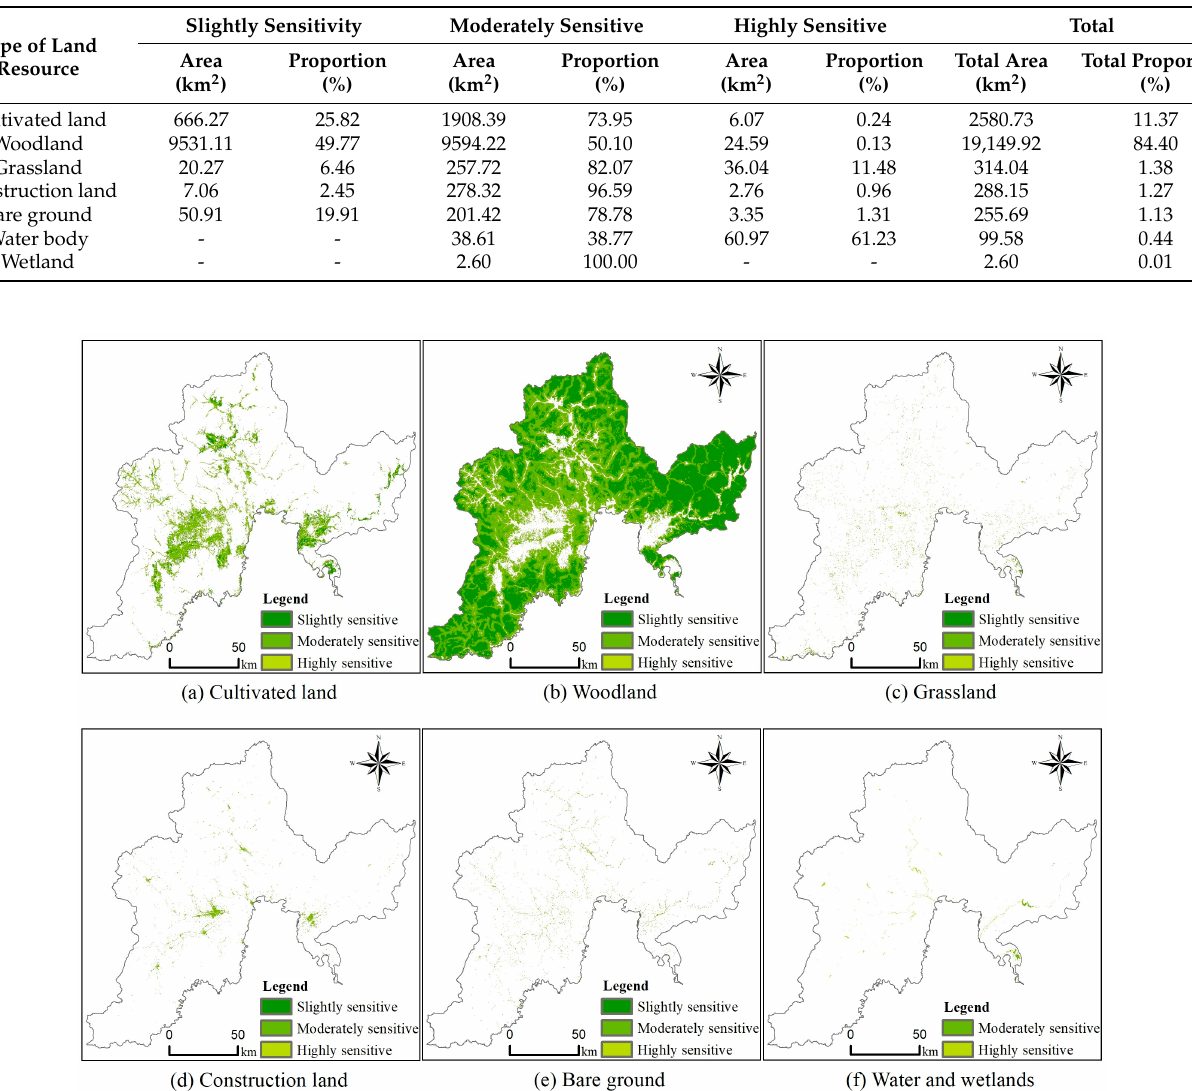
Table 8. Area and proportion of ecological sensitivity classi fi cation of various land resource types.